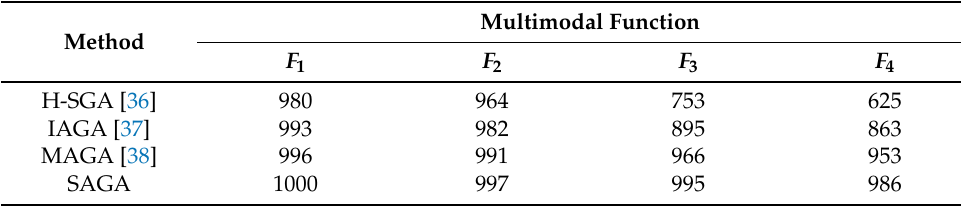
Table 1. The total number of convergences.